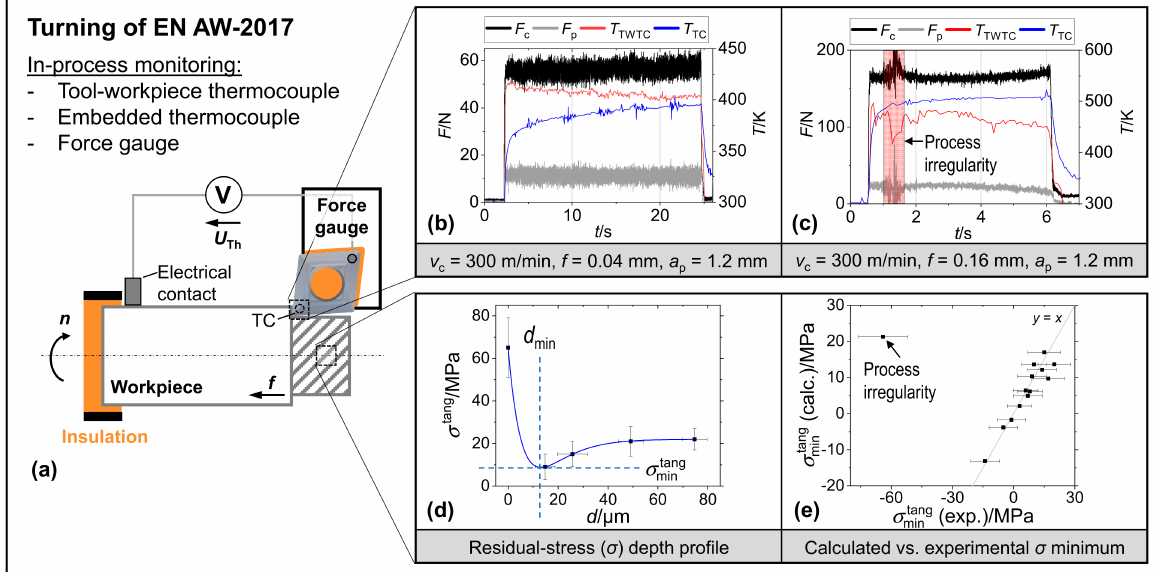
Figure 10. Identification of process irregularities by temperature ( T ) and force ( F ) measurements. ( a ) Schematic depiction of the measurement system, ( b ) Process-monitoring signals of a regular process, ( c ) Process-monitoring signals in the event of a process irregularity, ( d ) Measured residual-stress ( σ ) depth profile ( d —depth beneath the surface), ( e ) Predicted minimum of σ by multiple linear